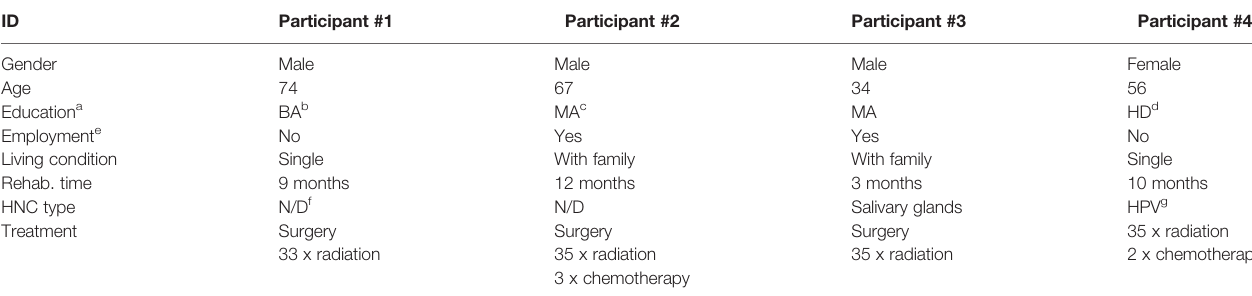
TABLE 1 | HNC patients ’ characteristics.